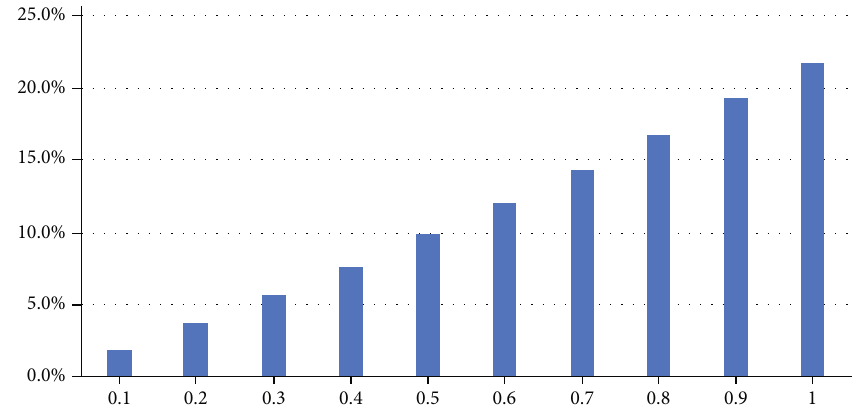
Figure 6: Market share of small producers based on the state